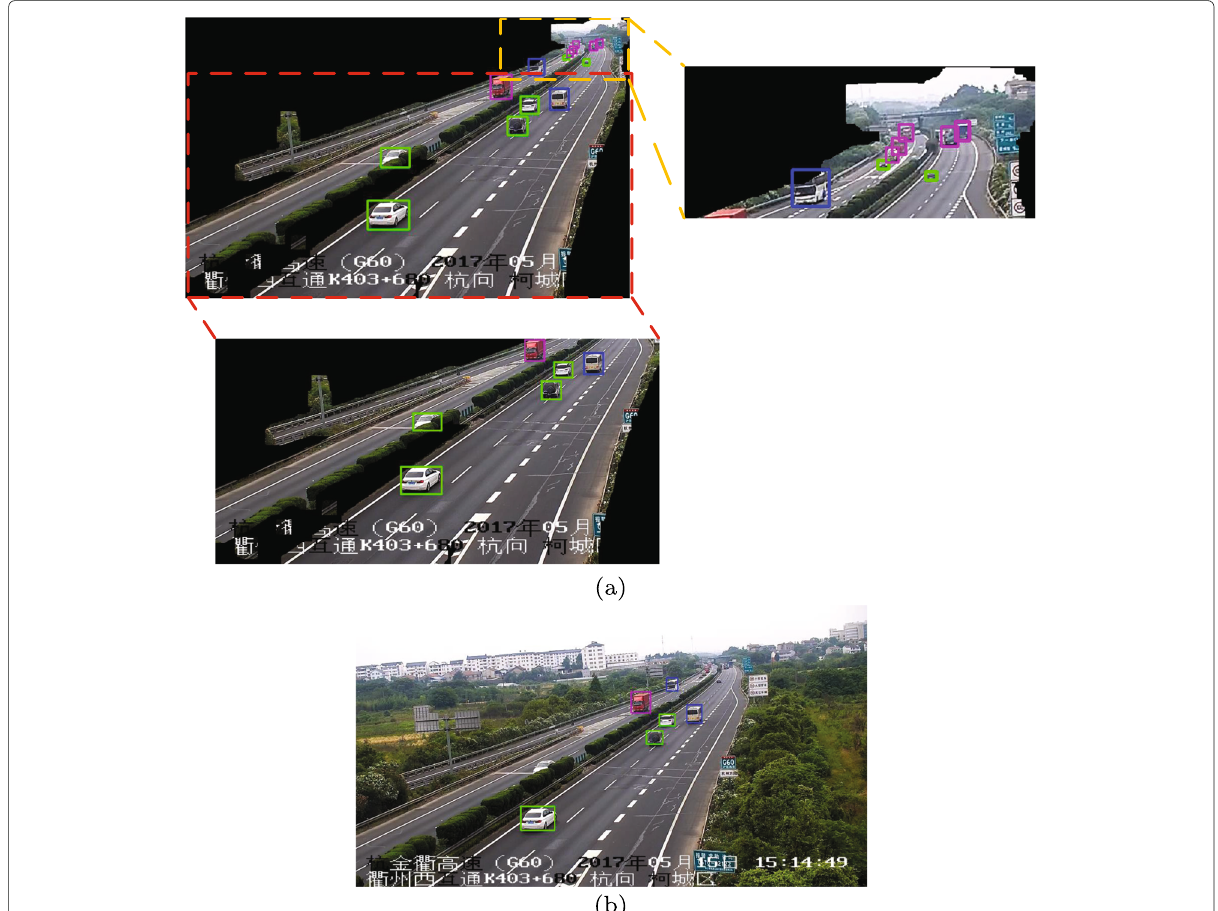
Fig. 13 Single-frame video object detection results. Green, blue, and fuchsia boxes are labelled to indicate the “car”, “bus”, and “truck” regions, respectively. a Our method; b the full-image detection